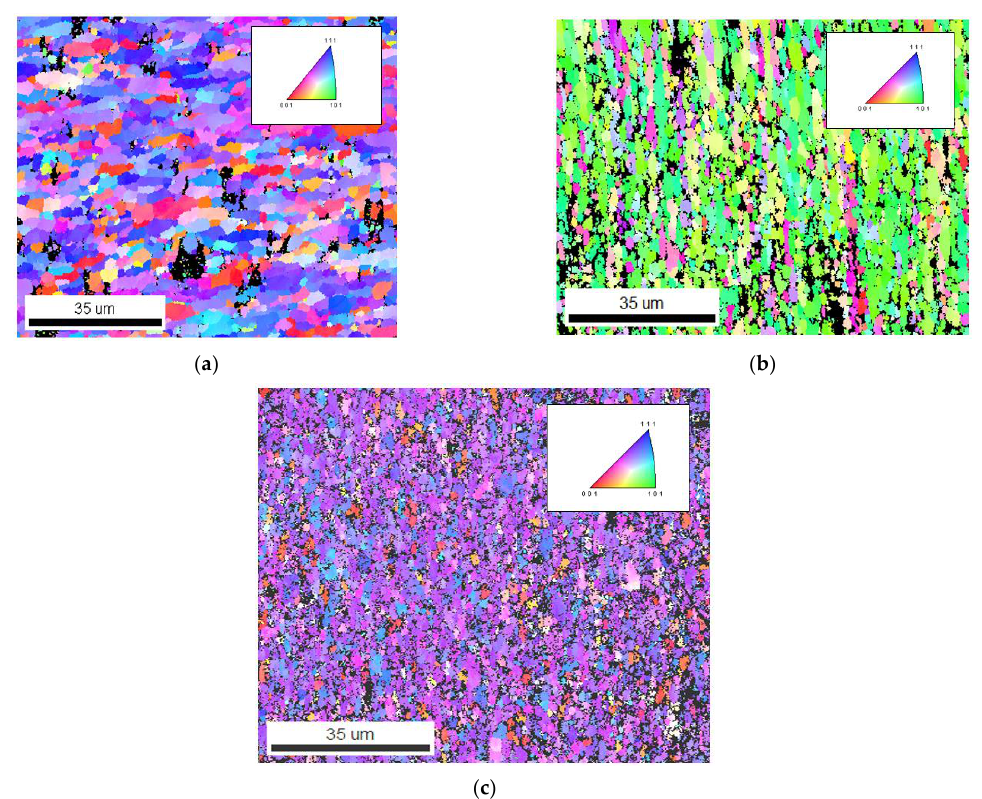
Figure 13. EBSD Maps of as sintered composite billets ( a ) AA 2024 – 2 wt% Graphene composites ( b ) AA 6061 – 2 wt% Graphene composites ( c ) AA 7075 – 2 wt% Graphene composite.